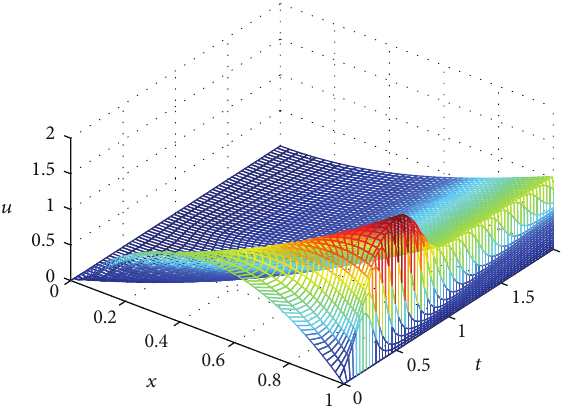
Figure 1: Numerical solutions for 𝜀 = 2 −4 and 𝑁 = 64 .